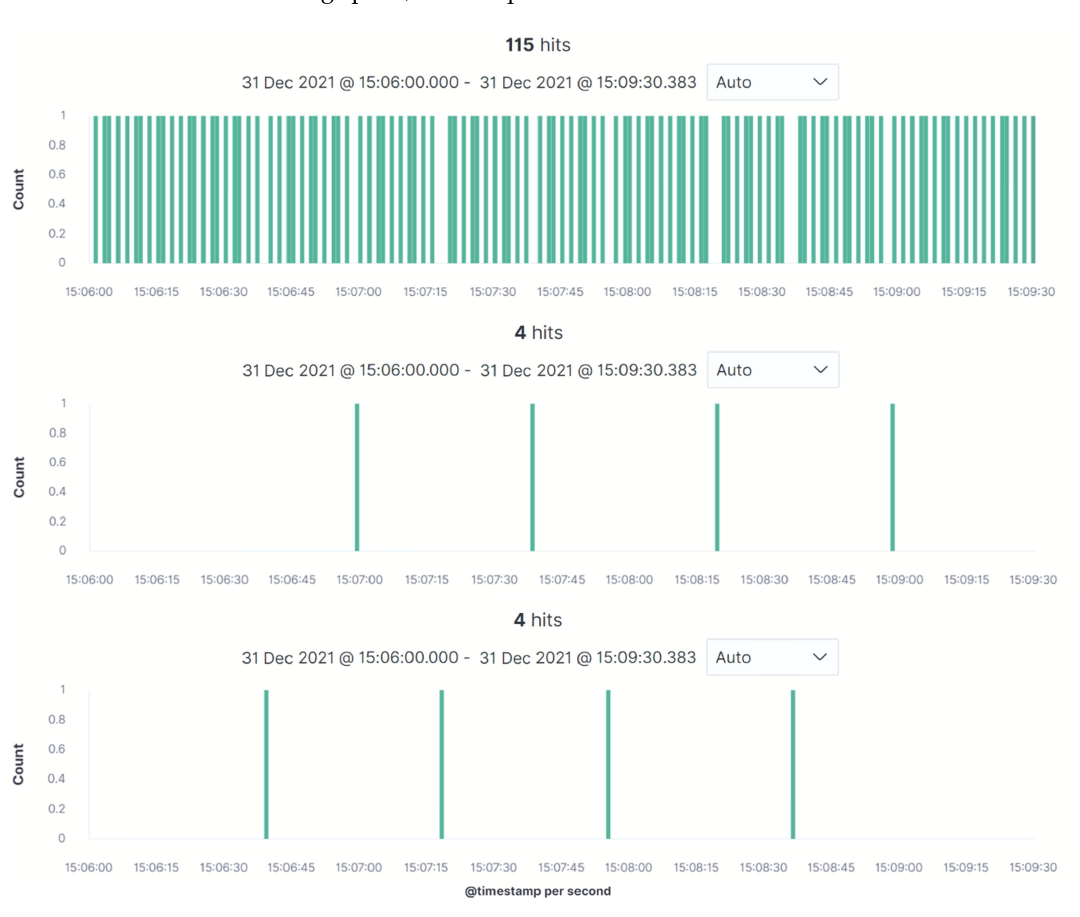
Figure 5. Visualization of the ATV’s condition data in Elasticsearch with Kibana.